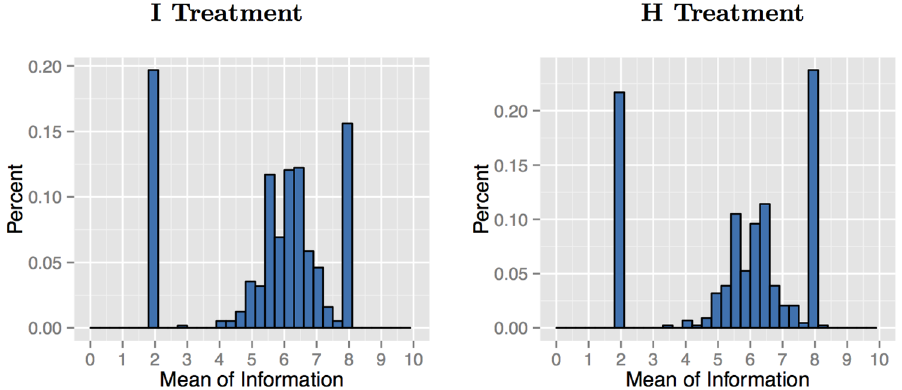
Fig 3. Standard Deviations of Observed Information Sets. Note: The spikes at 0.89 and 1.84 are from the experimenter-chosen information sets.